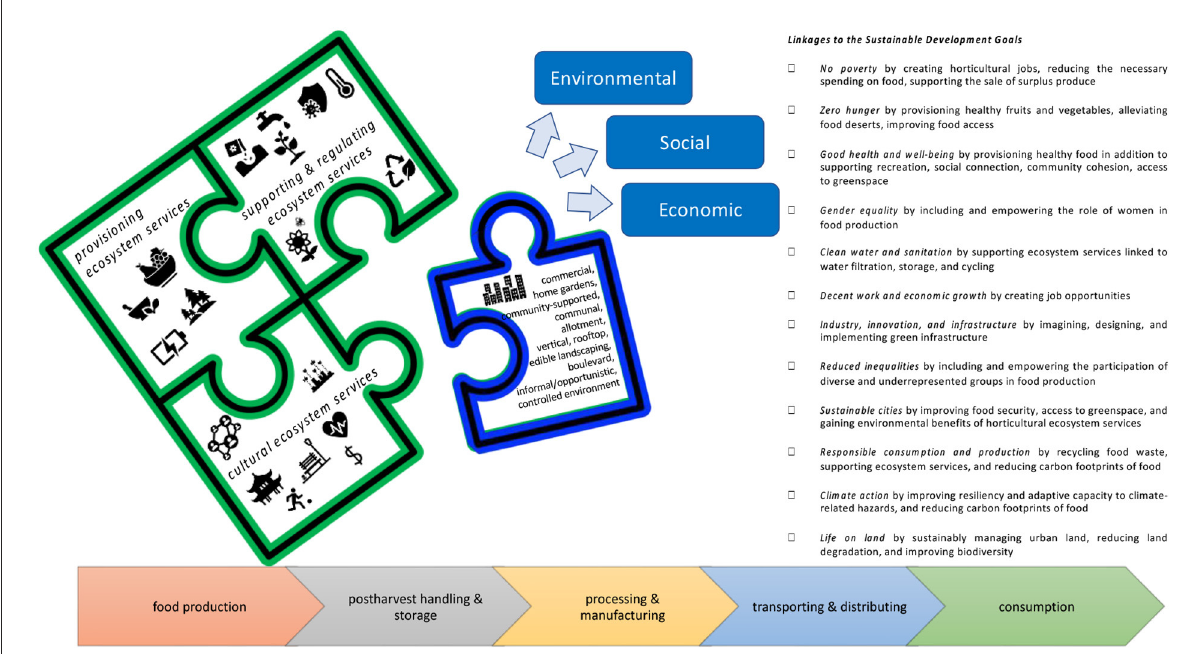
FIGURE1 The multifunctional ecosystem services provided by horticulture (outlined in green), if directly integrated into urban environments (outlined in blue), may offer hope toward the environmental, social, and economic dimensions of a sustainable food system and contribute to several sustainable development